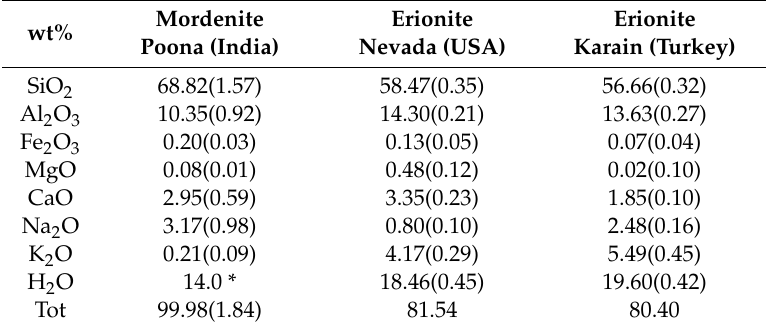
Table 2. Elemental composition of Poona mordenite and erionite from Nevada and Karain [64]. * Chemical data are renormalized using a theoretical water content of 14.0 wt%. Standard deviation in